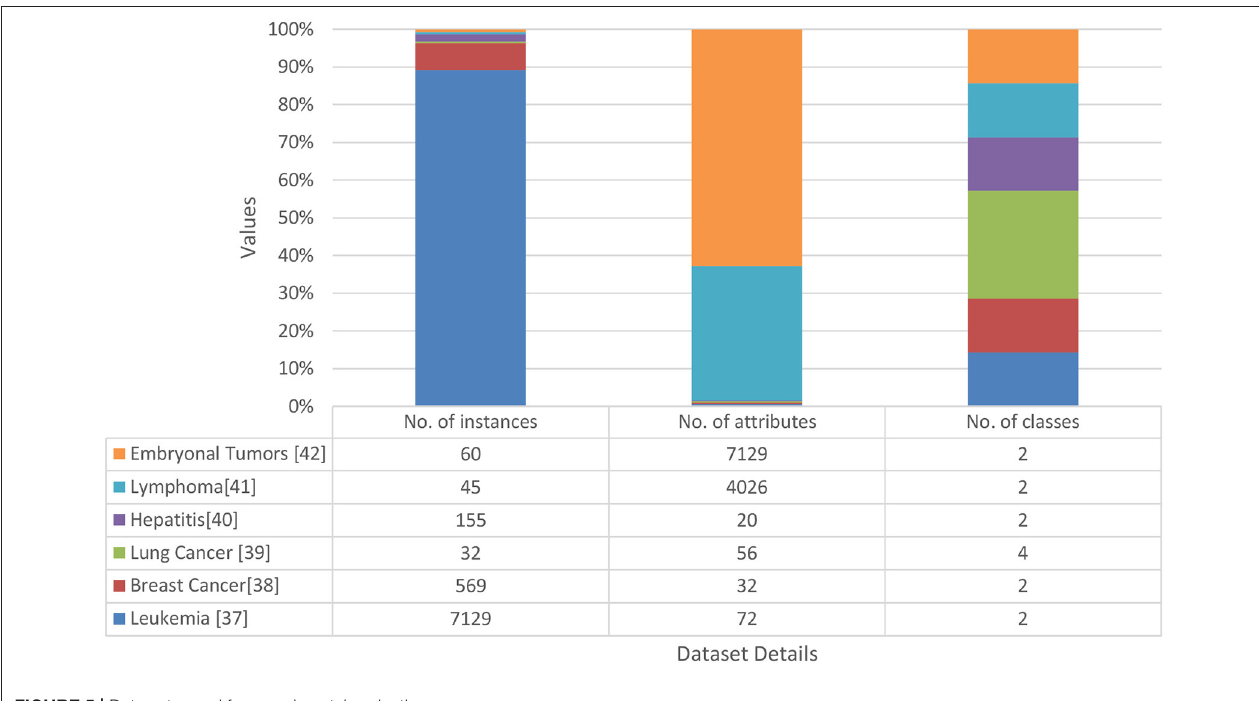
FIGURE 5 | Data sets used for experimental evaluation.